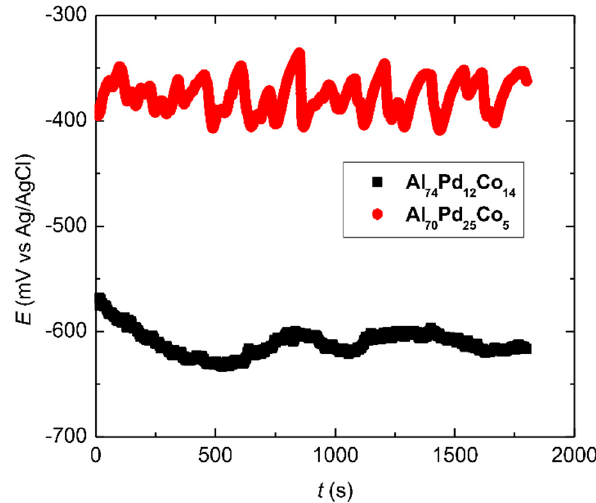
Figure 7. Open circuit potential of the as-solidified Al 74 Pd 12 Co 14 and Al 70 Pd 25 Co 5 alloys in 0.6 M NaCl. For the color interpretation of this figure, the reader is referred to the web version of this article.